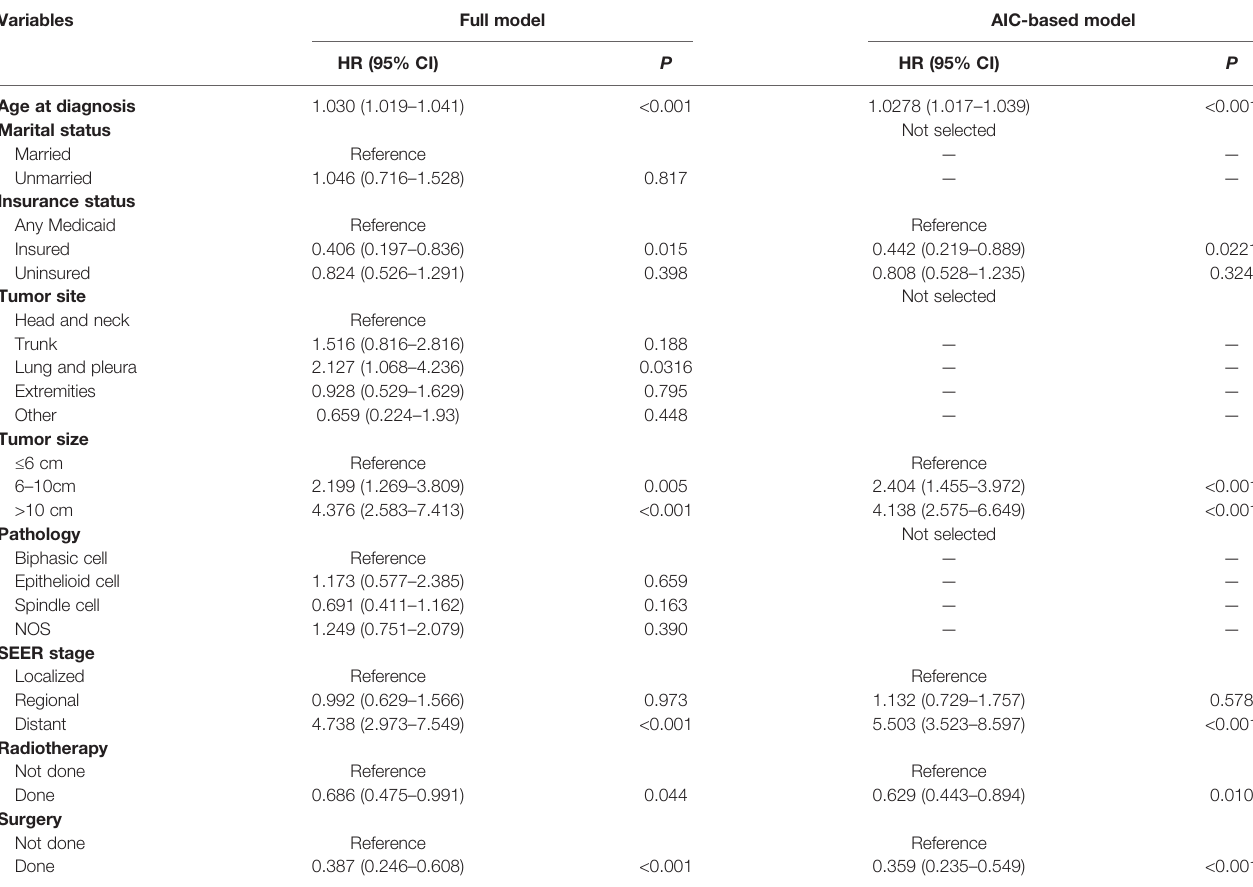
TABLE 4 | Multivariate Cox regression analysis for CSS of the SyS patients in the training